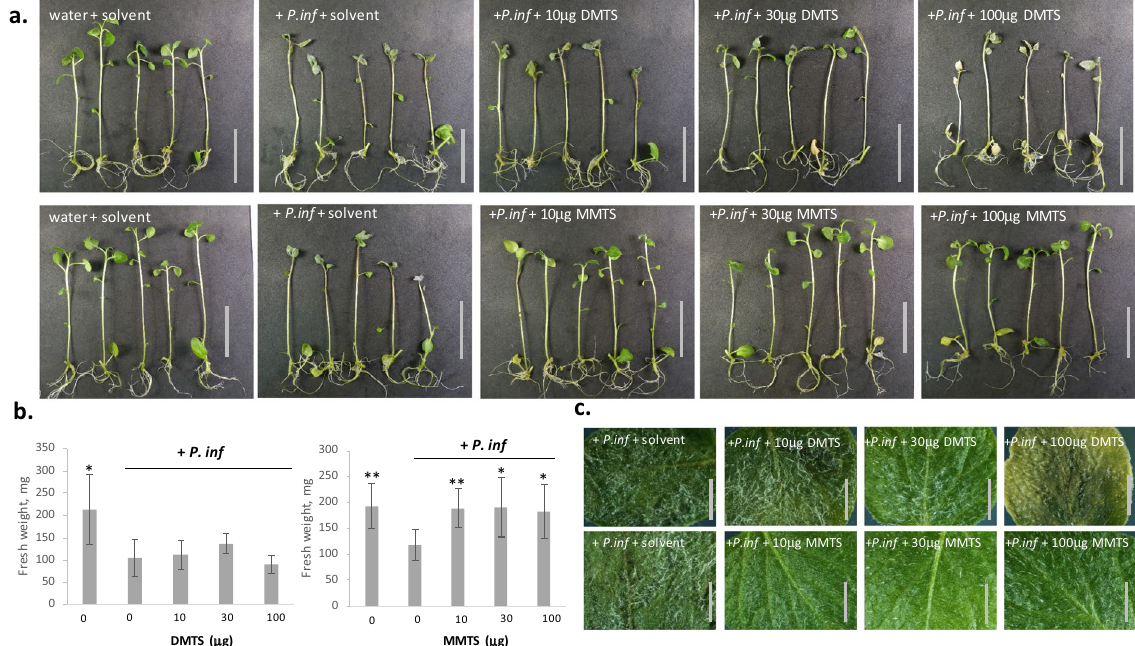
Figure 4. MMTS protects potato plantlets against late blight. (a) In vitro grown potato plantlets (cv Victoria) were inoculated with P. infestans and treated (from left to right) with 0, 10, 30 and 100 µ g DMTS (upper panel) and MMTS (lower panel) respectively. Scale bar = 5 cm. ( b ) The fresh weight was measured for the respective plantlets. The bars show averages of ten individual plantlets with error bars indicating standard deviation. Significant differences between the infected controls and the samples according to an ANOVA test are marked by asterisks: * p < 0.01; and ** p < 0.001. ( c ) Representative pictures taken at the binocular. Scale bars = 3